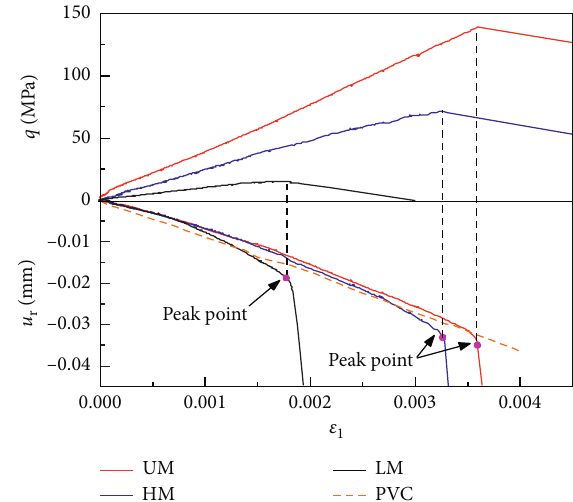
Figure 11: q - ε 1 and u r - ε 1 relationships between the mortar specimens with three strengths and the PVC pipe.